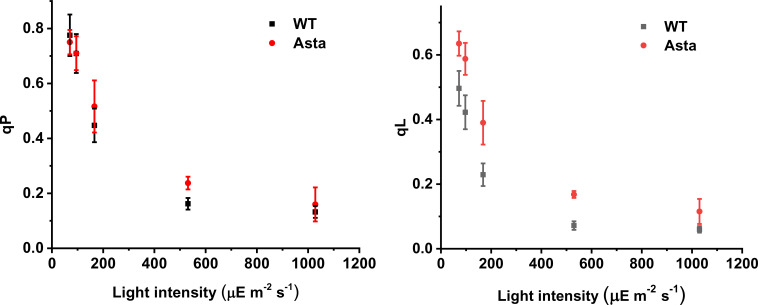
qP (A) and qL (B) as a function of light intensity in WT and Asta leaves.(Average values ± SD are shown for n = 3 leaves/plants, biological replicas.).